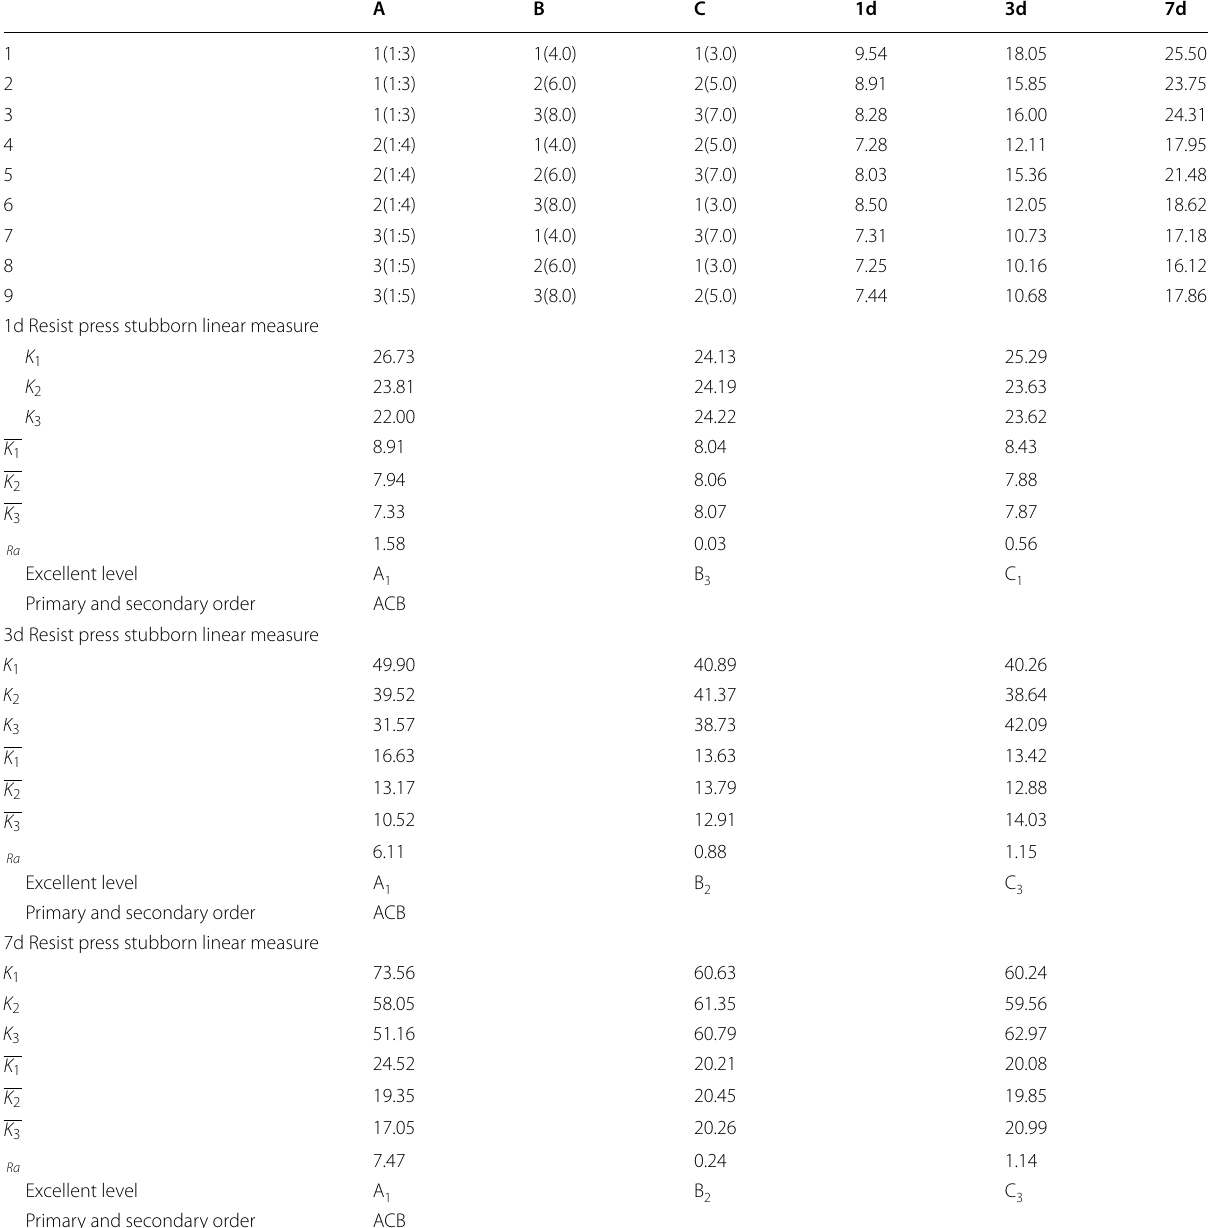
Table 11 Analysis of extreme compressive strength of